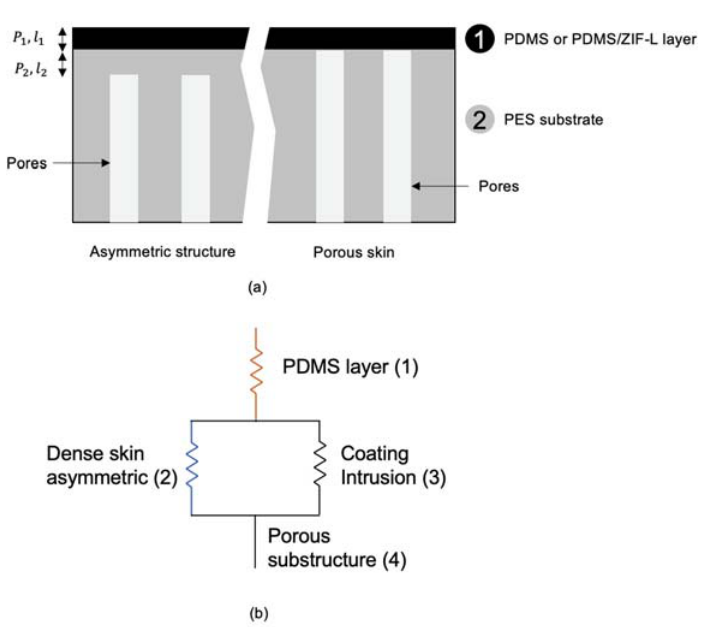
Figure 1. Illustration of ( a ) composite membrane and ( b ) analogous electric circuit.